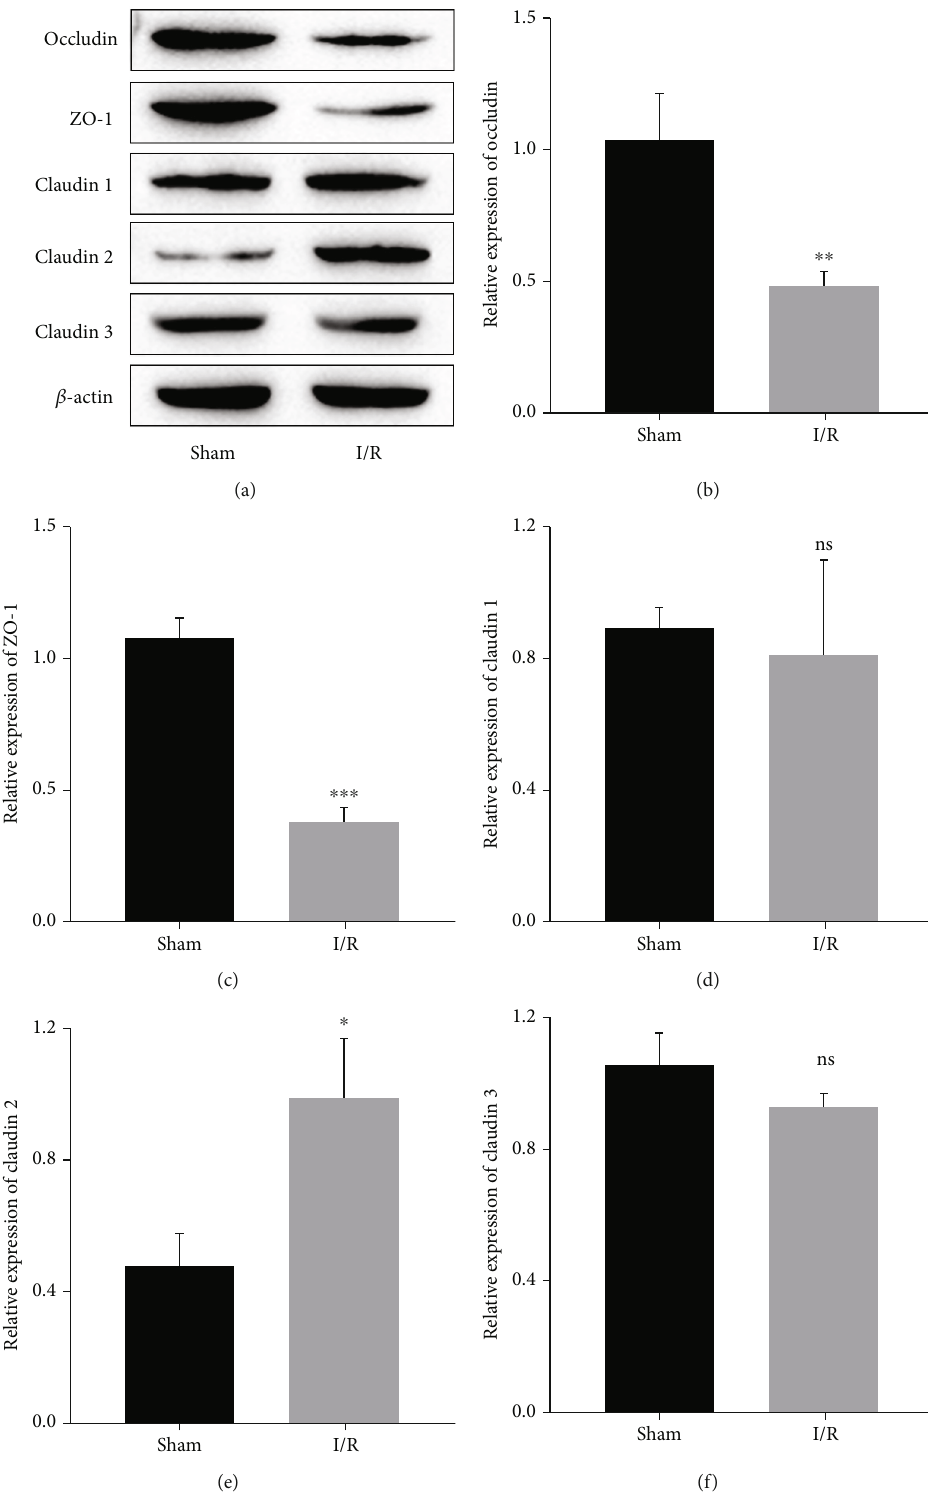
Figure 2: Changes in TJP expression after intestinal IRI. (a) Representative Western blot bands. (b – f) The relative expression levels of occludin, ZO-1, claudin-1, claudin-2, and claudin-3. ns P > 0 : 05 , ∗ P < 0 : 05 , ∗∗ P < 0 : 01 , and ∗∗∗ P < 0 : 001 vs. the sham group. n = 5 per